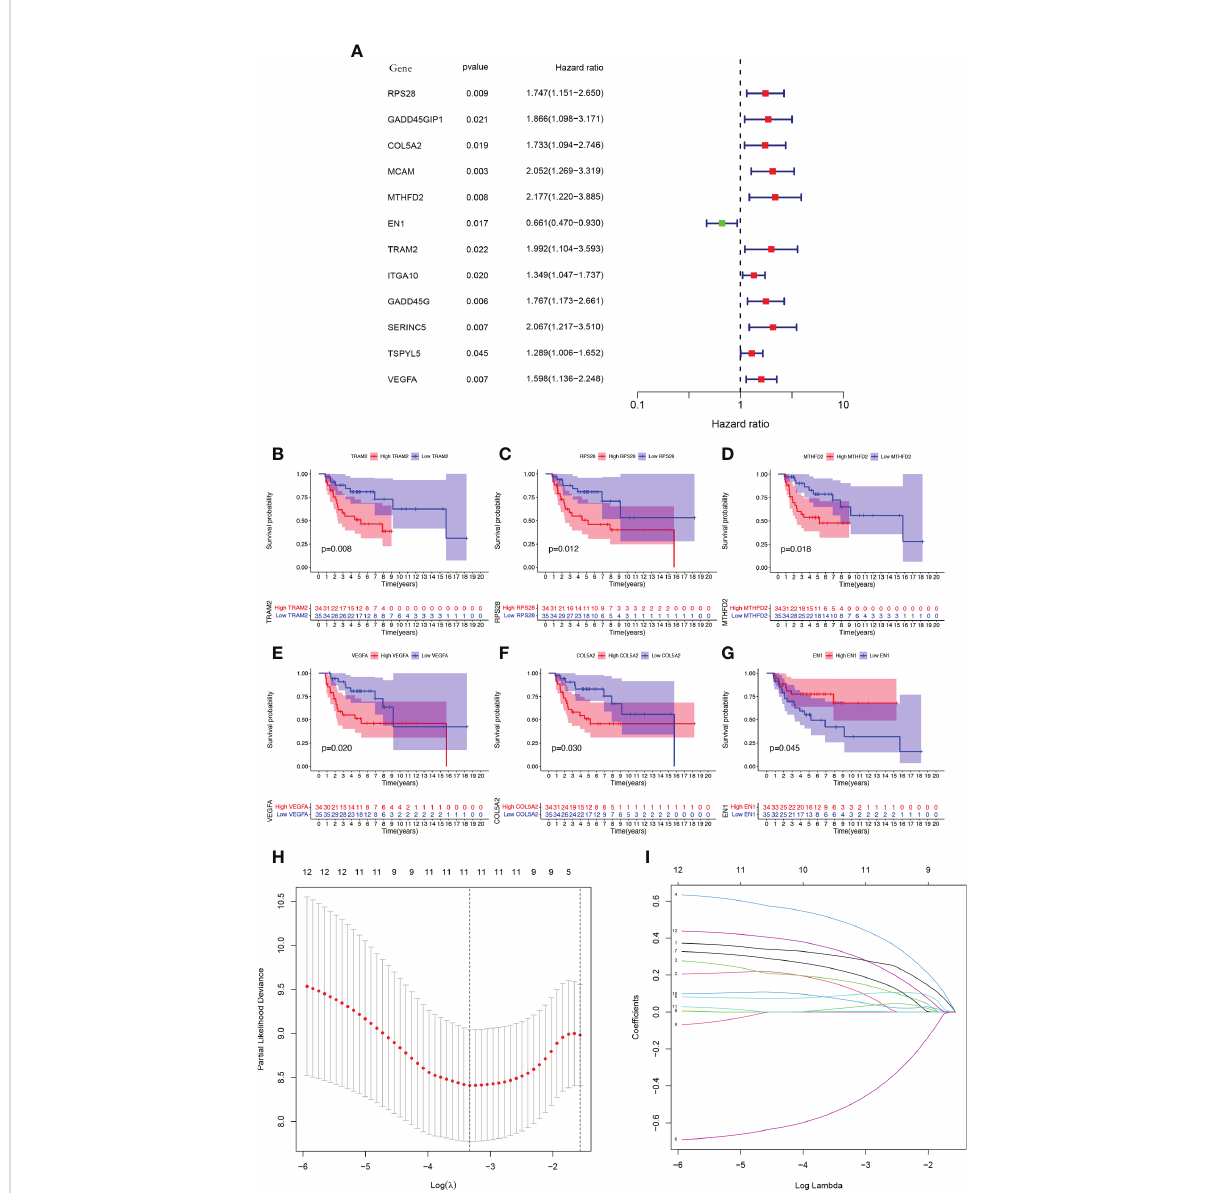
FIGURE 4 Construction of a GCSRGs prognostic signature in training cohort. (A) Forest plot of univariate cox regression analysis of the survival-related 12 differentially expressed genes. (B – G) Kaplan-Meier survival curves of patients with differential expression of prognosis-related genes. (H) Obtainment of the optimal l value. (I) The LASSO Cox analysis identi fi ed 5 genes associated with